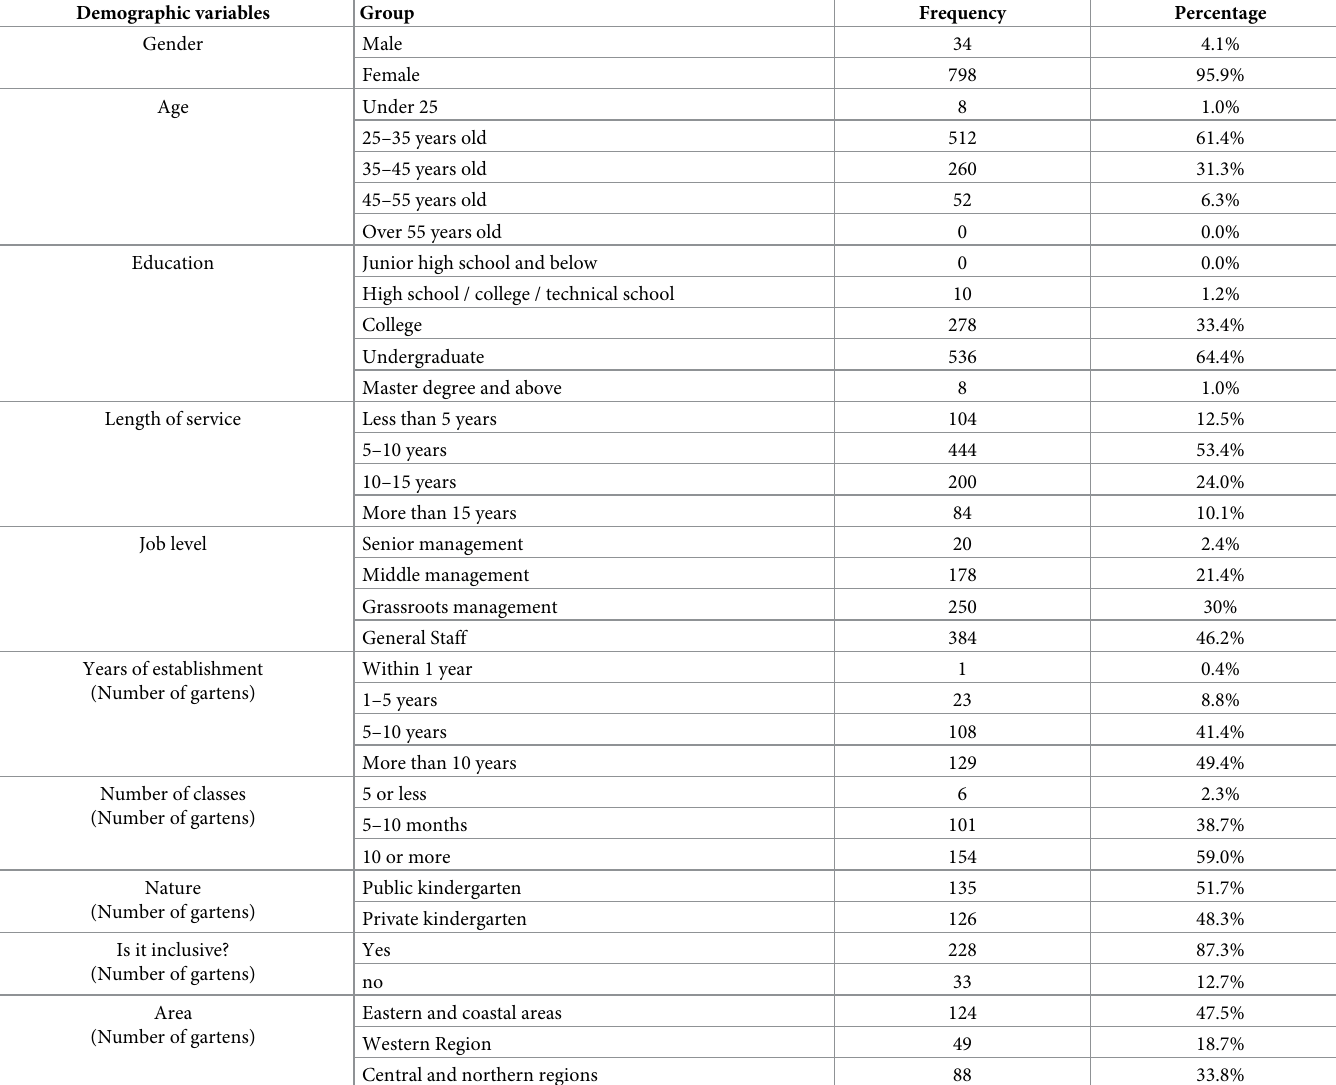
Table 3. Demographic characteristics of the